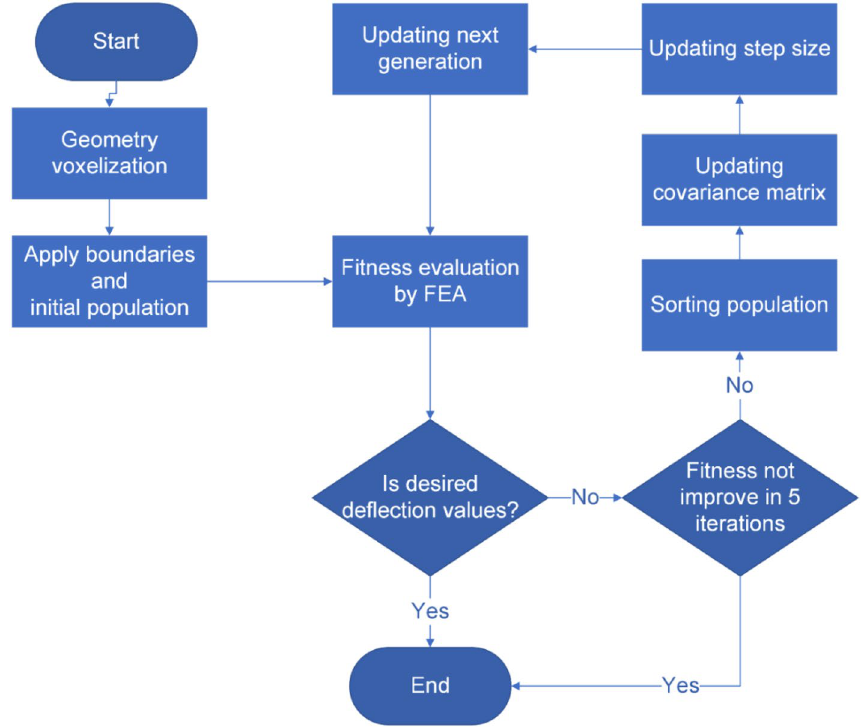
Figure 1. The flowchart of the overall optimisation scheme based on the implementation of the CMA-ES algorithm with MATLAB and Comsol Multiphysics solution for the beam deflection problem.